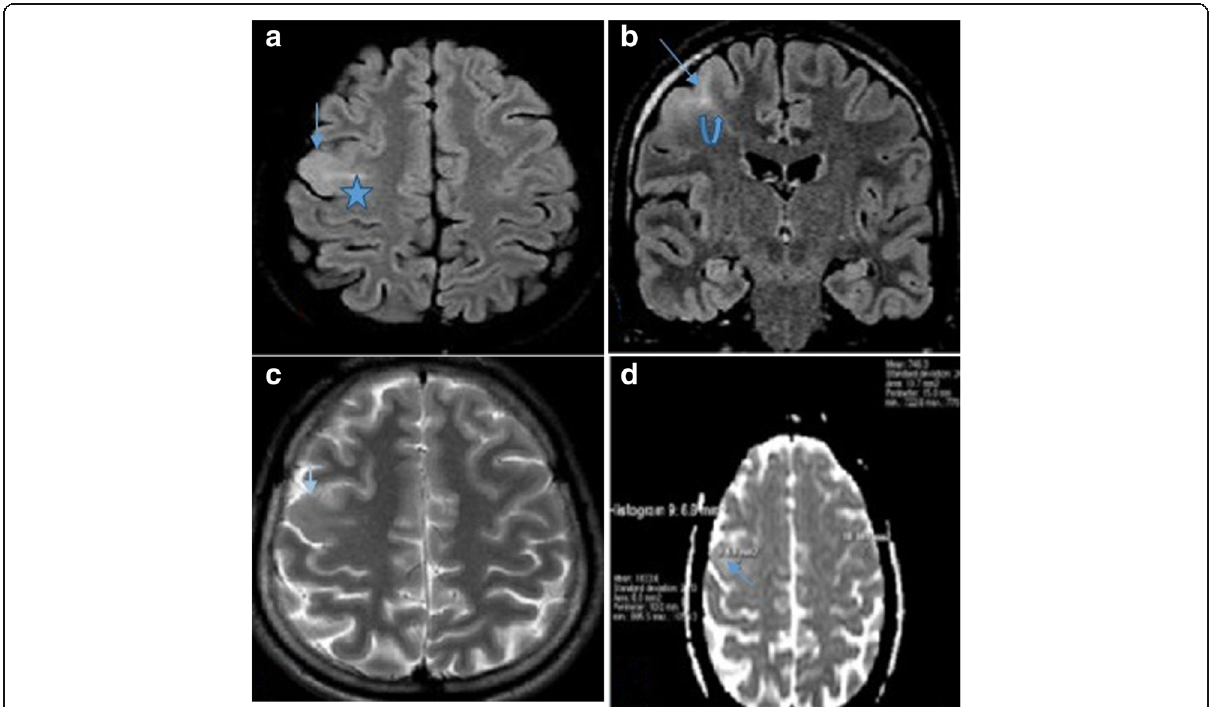
Fig. 2 A 35-year-old male patient with epilepsy. a Cortical signal change in axial FLAIR sequence-blurring in GW matter interface (arrow) and transmantle sign (star). b Cortical signal change in coronal FLAIR sequence-blurring in GW matter interface (arrow) and transmantle sign (thick arrow). c Increase in cortical signal intensity-blurring in GW matter interface. d Hyperintense area in axial dADC sequence, ADC measurement from this area and from a symmetrical